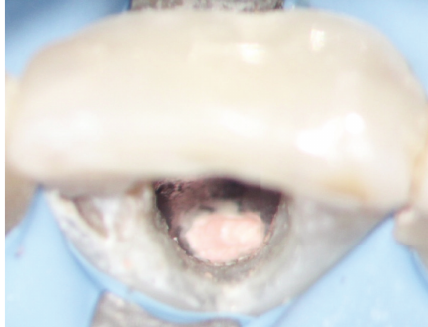
Figure 7: Access cavity with permanent root filling in place.